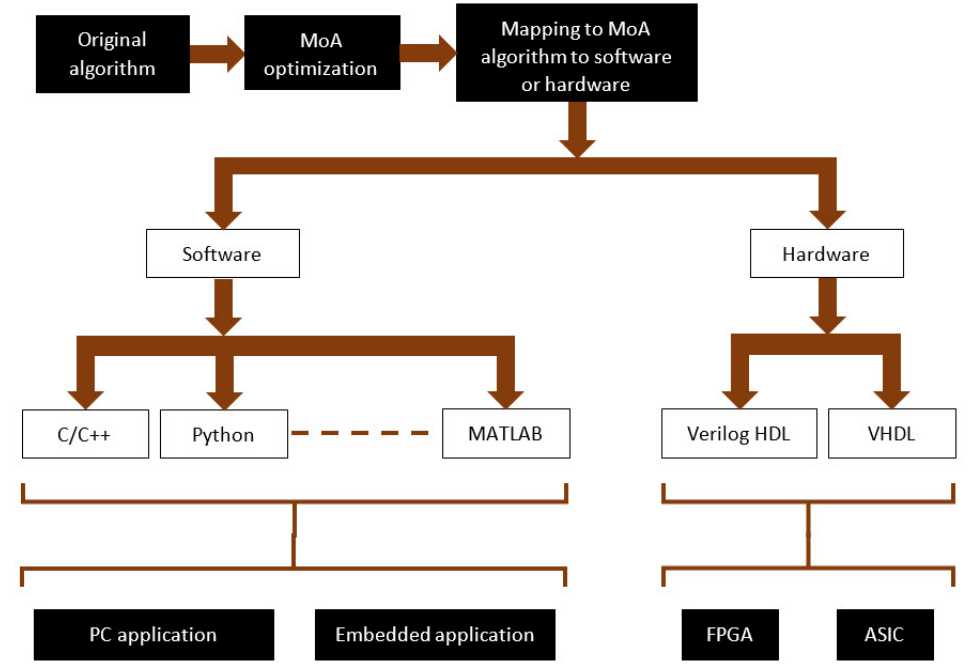
Figure 4. MoA optimization and technology